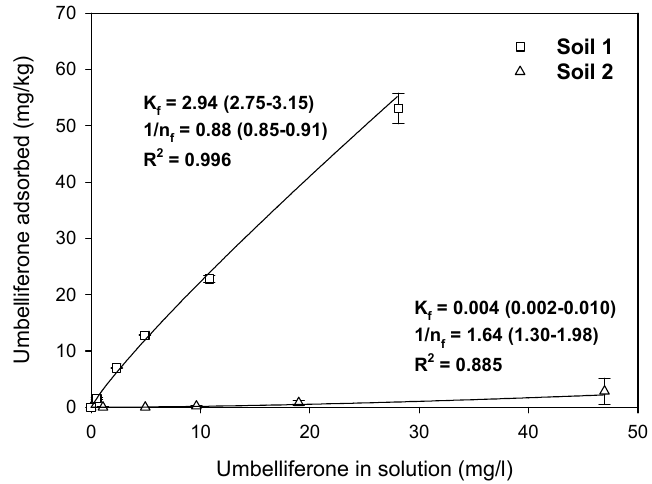
Figure 2. Umbelliferone adsorption isotherms on the two soils selected for the study. Symbols represent experimental data points, whereas lines are the Freundlich-fit adsorption isotherms. The Freundlich coefficients for each isotherm are indicated in the graph. Table 1. Physicochemical properties of the soils selected for this work.